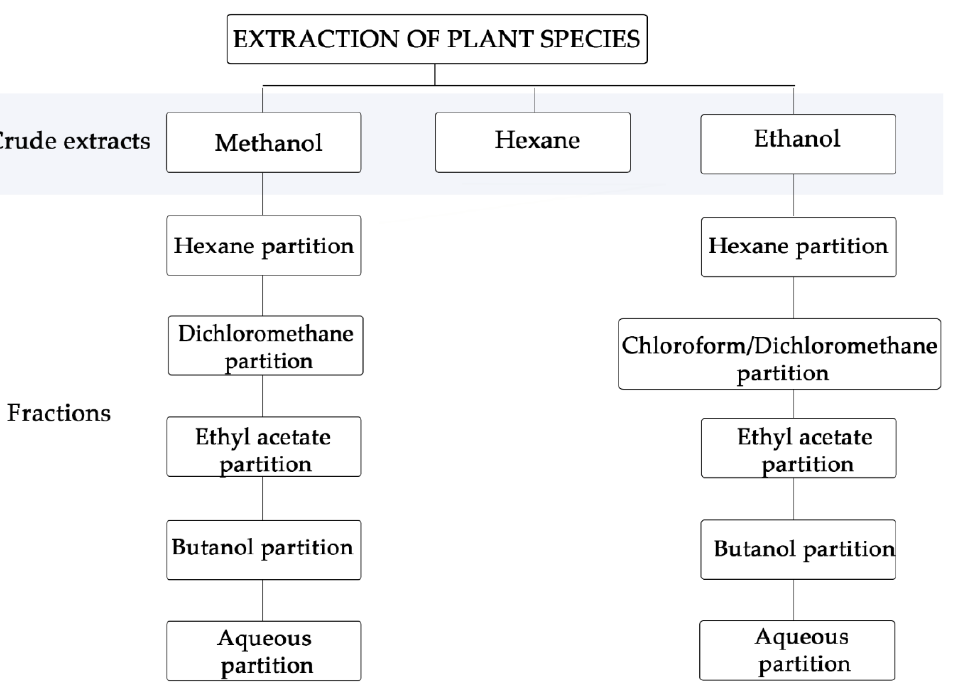
Figure 1. Extraction scheme of extracts and fractions from Brazilian botanic sources.